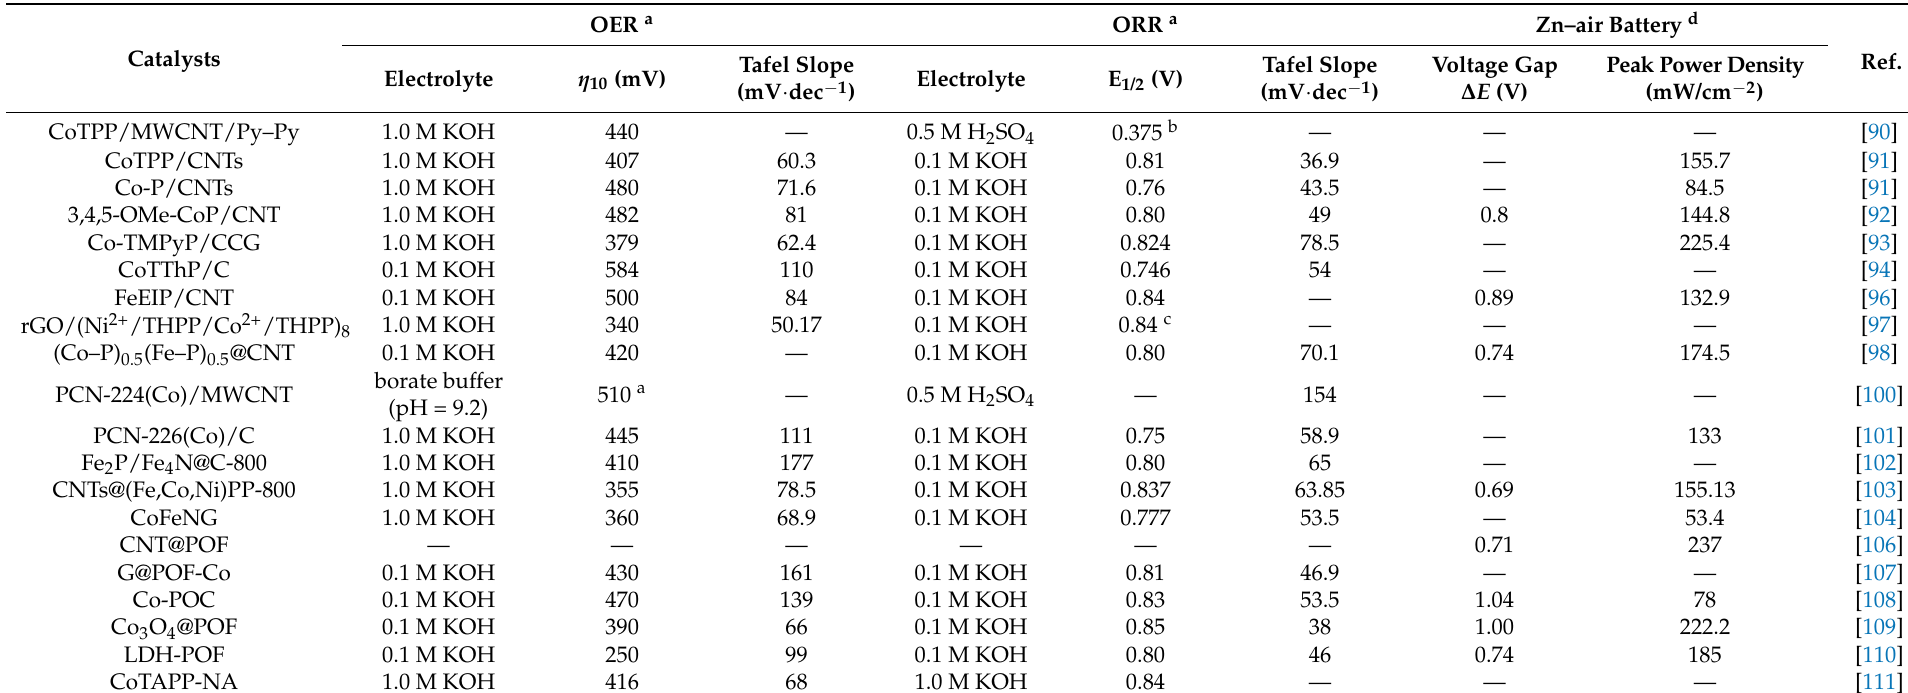
Table 2. Summarized performances of porphyrin-based materials for bifunctional oxygen electrocatalysts and Zn–air